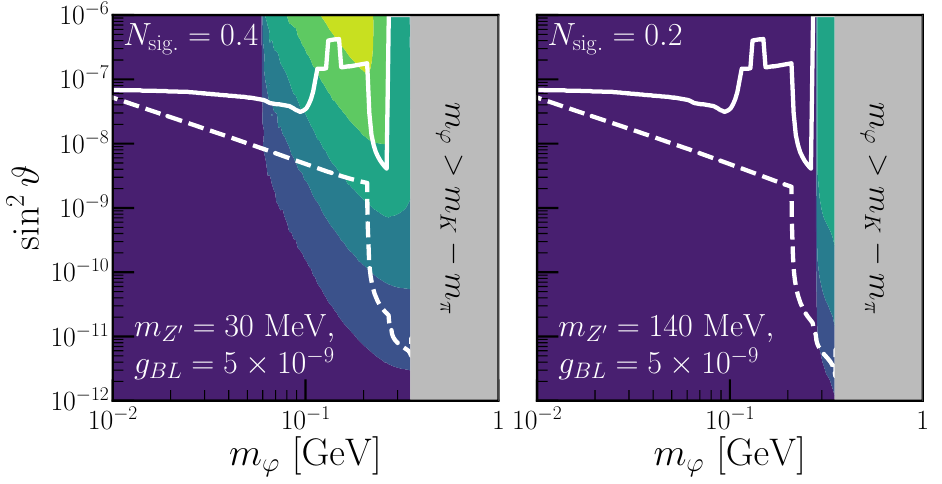
Figure 6 . Expected number of signal events of Z 0 decays in ten years of data collection at DUNE, assuming two benchmark parameters as given in eqs. (2.9) (left panel) and (2.10) (right panel). The different colored contours represent increasing signal events (from darker to lighter colors) by an order of magnitude each, purple corresponding to N contribution is purely from direct production (meson decays and proton-proton bremsstrahlung), where ϕ → Z 0 Z 0 production increases the signal rate when m show a collection of current constraints from section 3.2.2 on m we show the expected DUNE sensitivity to search for the ϕ decays. In the vertical gray shaded regions, the production of ϕ from Kaon decay is kinematically